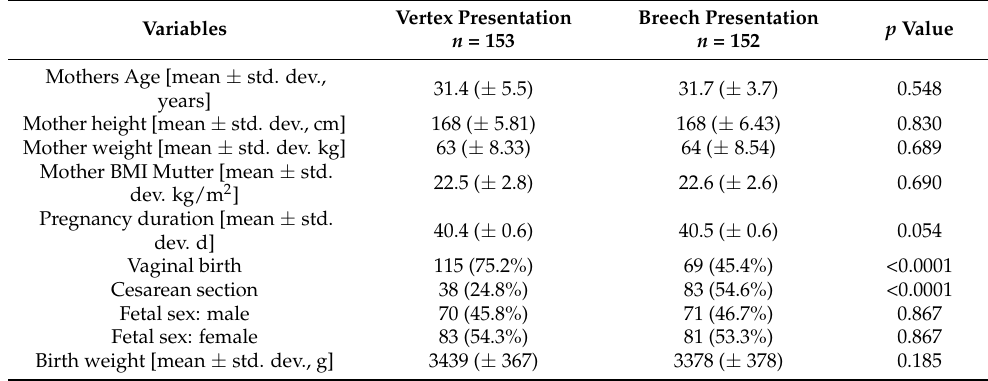
Table 1. General variables of pregnancies in vertex position group and breech presentation